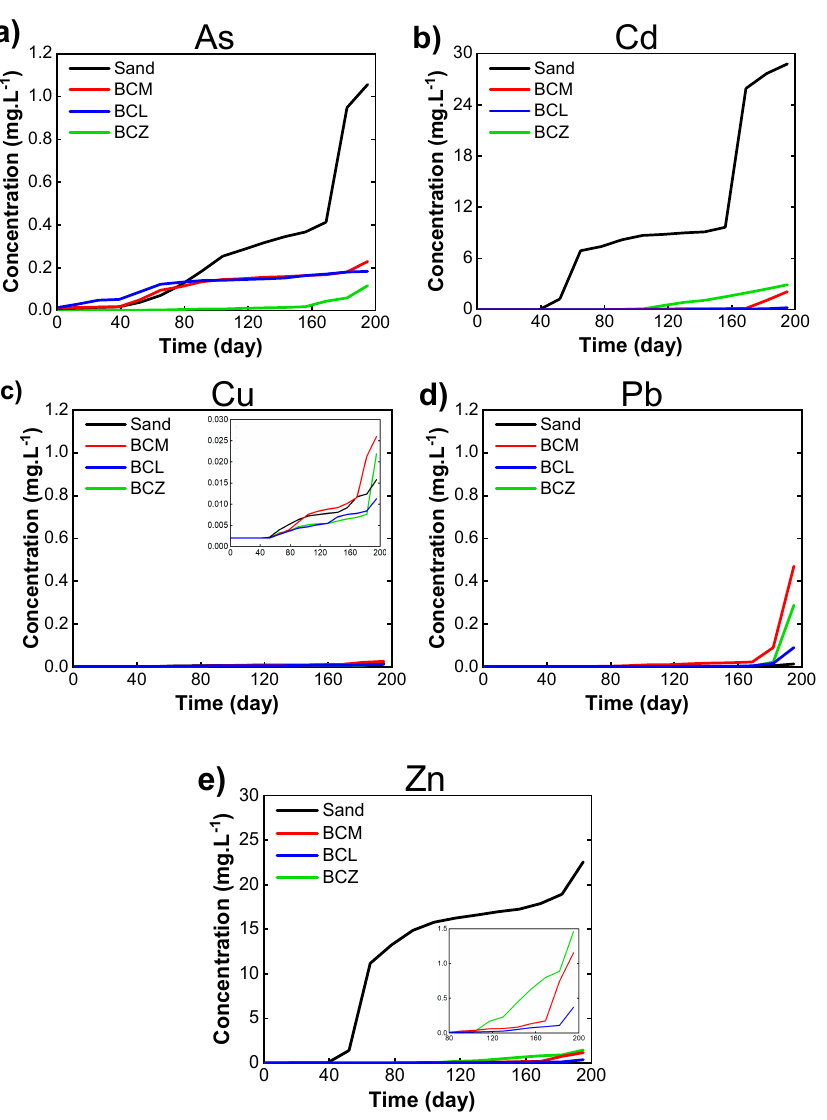
Figure 5. Concentration changes of ( a ) As; ( b ) Cd; ( c ) Cu; ( d ) Pb; and ( e ) Zn in the effluents from different column configurations (Sand, BCM, BCL, and BCZ) with respect to time.